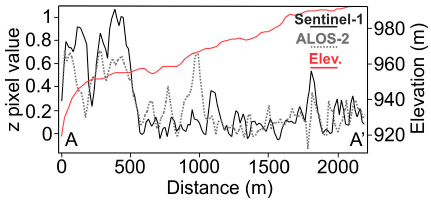
Figure 12. DPM profiles (Sentinel-1 in black and ALOS-2 in gray) and topographic profiles (SRTM 30 m in red) along A–A’ shown in Figure 9.